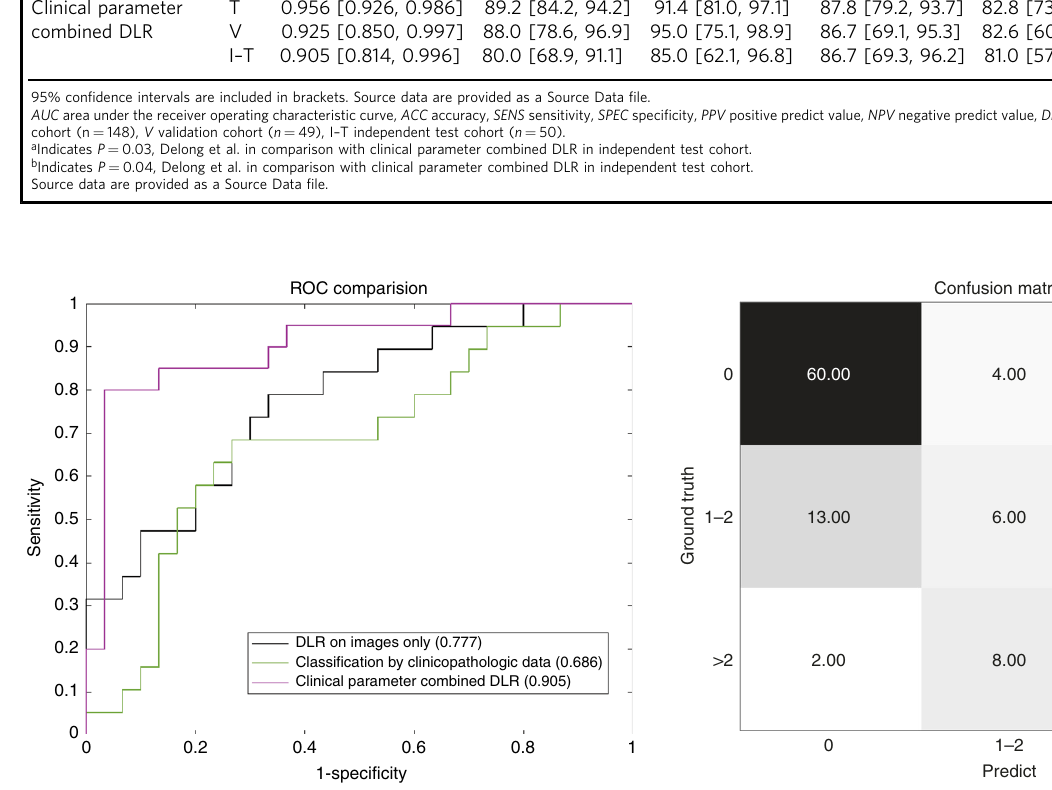
Fig. 3 Receiver operating characteristic (ROC) curves comparison between different models for predicting low metastatic burden of axillary disease (N + (1 – 2)) and heavy metastatic burden of axillary disease (N + ( ≥ 3)). DLR deep learning radiomics. Numbers in parentheses are areas under the receiver operating characteristic curves. Source data are provided as a Source Data fi le.